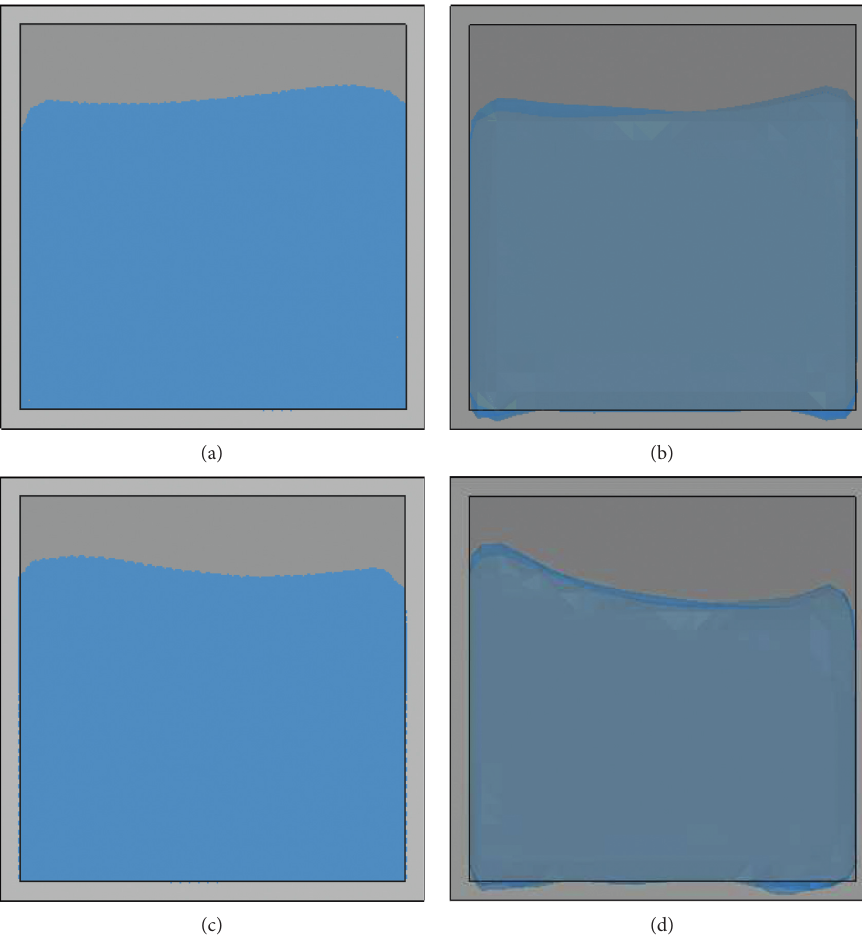
Figure 4: Comparison of the sloshing pattern between the two algorithms. (a) At 0.8s with the SPH-FEM algorithm, (b) at 0.8s with the CEL method, (c) at 1.6 s with the SPH-FEM algorithm, and (d) at 1.6s with the CEL